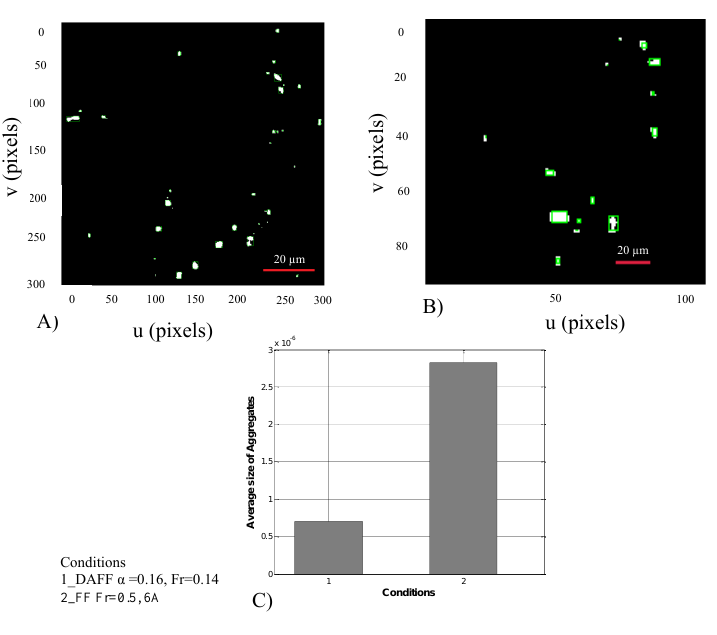
Figure 12. Aggregation of fluorescent magnetic nanoparticles (FMNPs) after crossing the blood–brain barrier (BBB) with different magnetic field functions (FFs). Aggregates under ( A ) discontinuous asymmetrical field function (DAFF), and ( B ) field function (FF); ( C ) MNP accumulation under (1) DAFF ( t ) of 6 A, α = 0.16 and 0.144 Hz; and (2) FF ( t ) of 6 A and 0.5